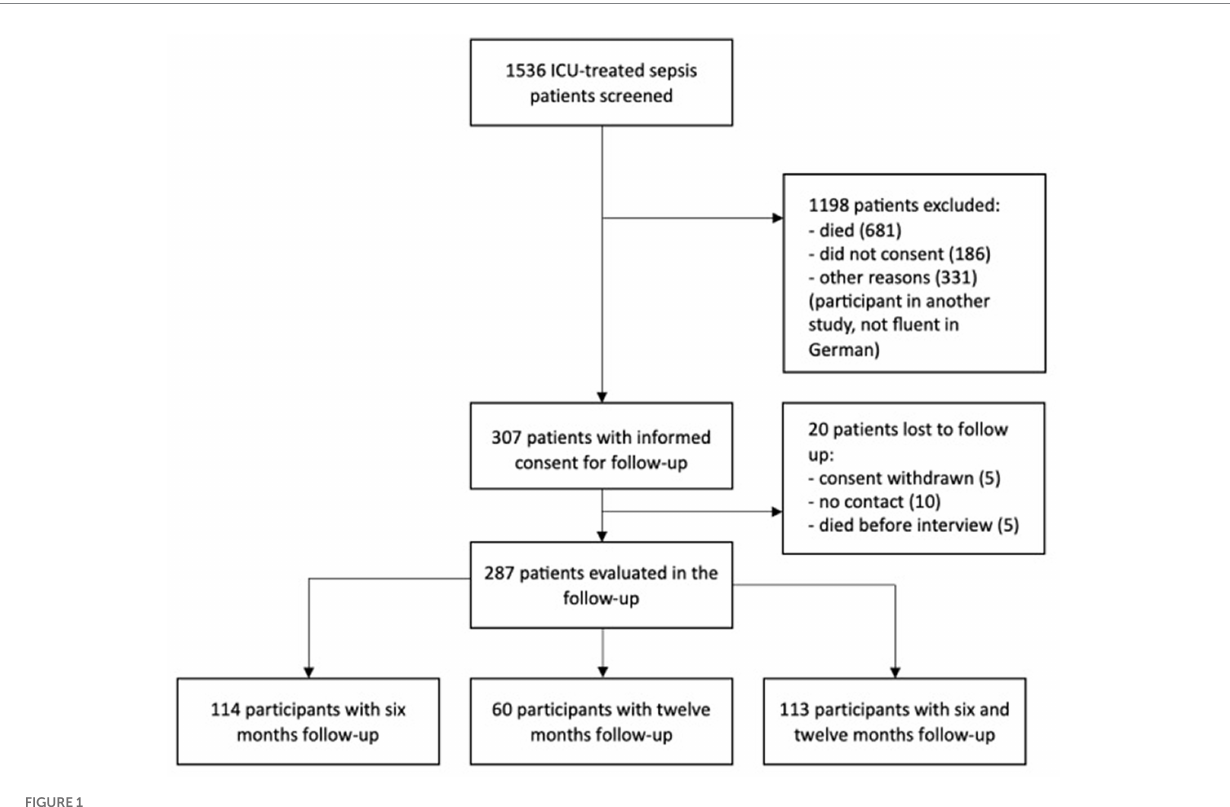
FIGURE 1 Flow of patient